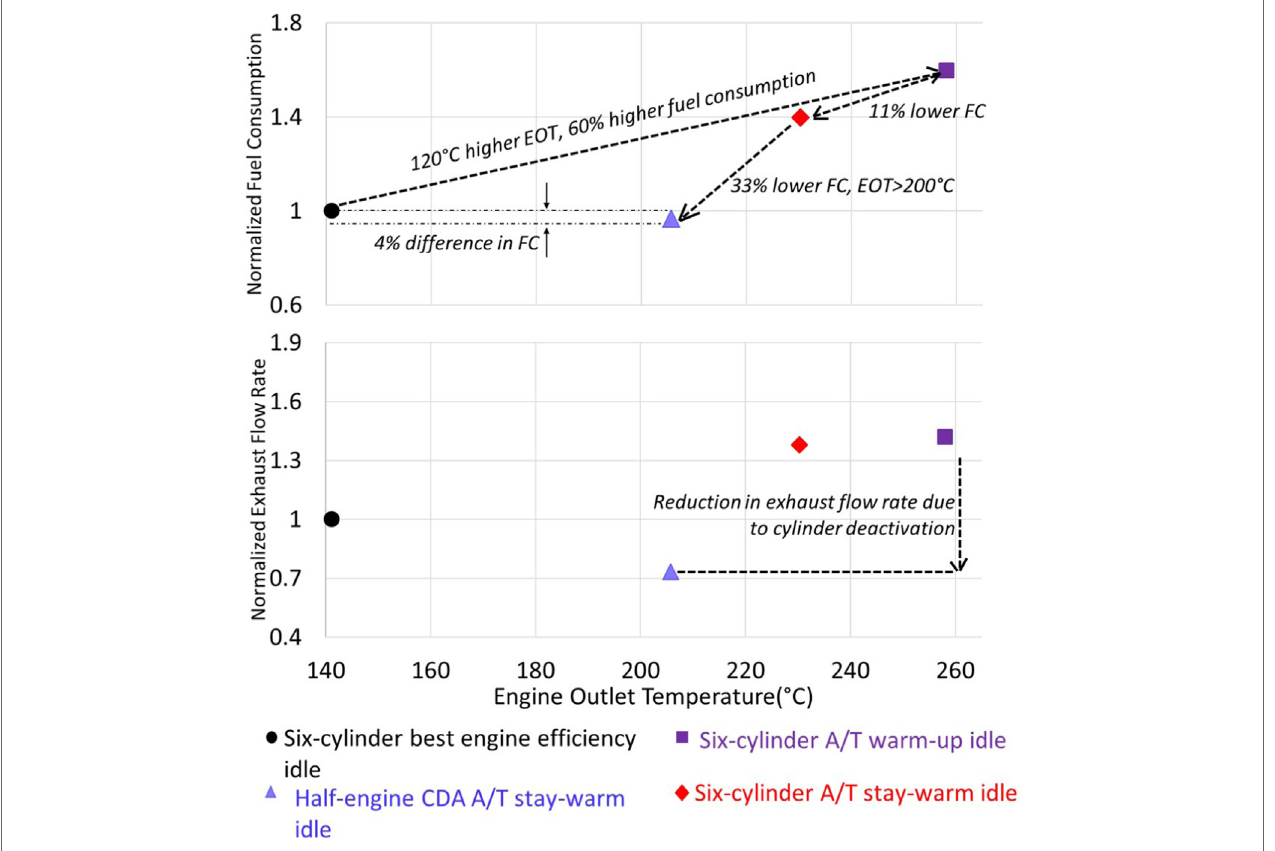
FigUre 8 | Experimental results from 800 RPM/1.3 bar idle. “Six-cylinder A/T warm-up idle” strategy enables fast A/T warm-up via elevated engine-outlet temperatures and flow rates, albeit at the expense of increase fuel consumption. The “Half-engine CDA A/T stay-warm idle” strategy enables fuel-efficient A/T component temperature maintenance via elevated engine-outlet temperatures, low exhaust flow rate, and low fuel